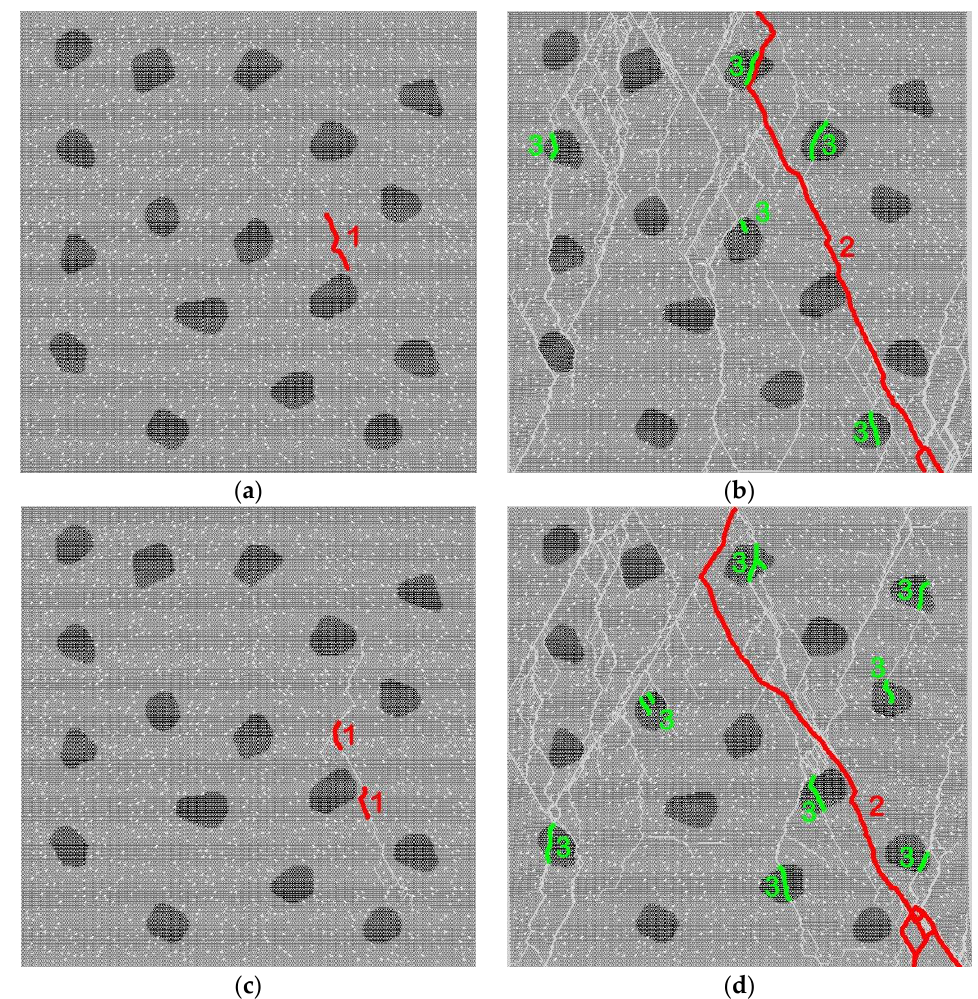
Figure 5. Fracture of model water-saturated concrete samples with capillary and microscopic pores at different values of Da : 0.5 ( a , b ); 140 ( c , d ). Figures ( a , c ) show the beginning phase of fracture, while figures ( b , d ) show broken samples. Primary short cracks originating from damage to the mesopore walls are shown in ( a , c ). They are marked by the red lines and indicated by the number 1. The main cracks in ( b , d ) are marked by the red line and indicated by the number 2, the intraparticle cracks (green lines) are indicated by the number